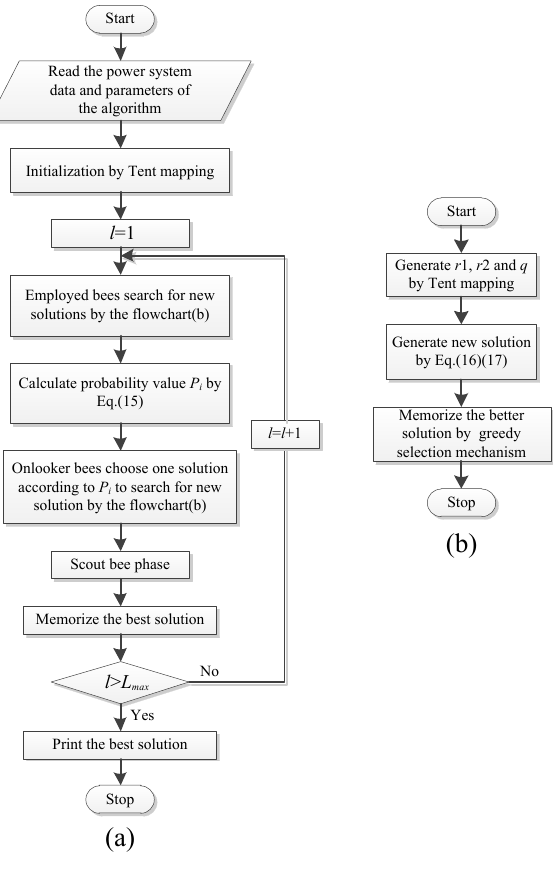
Figure 2. Flowchart of the IABC